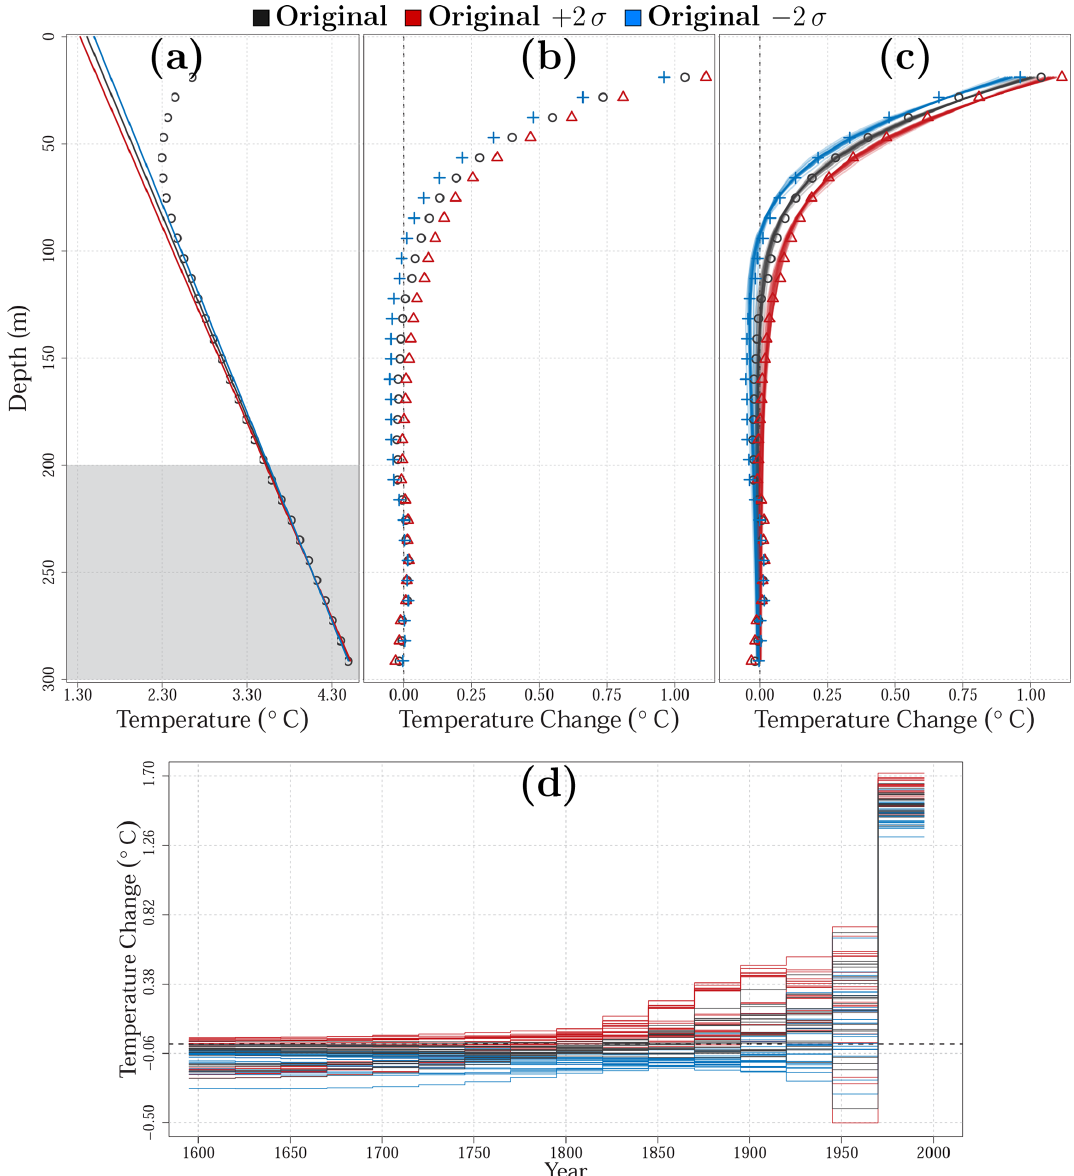
Figure 2. Borehole temperature profile measurements at Fox Mine (CA_9519), Manitoba (Canada), as an example to explain the inversion approaches in this study. (a) Observed original profile (black dots), the estimated subsurface quasi-equilibrium temperature profile (black line), and the two extremal temperature profiles (red and blue lines) displaying the error in determining the quasi-equilibrium profile. All three equilibrium profiles were estimated from the linear regression analysis of the deepest part of the measured profile (from 200 to 300m, grey zone). (b) Anomaly profiles estimated by subtracting the three equilibrium profiles from the original temperature profile. (c) As in (b) , but including the 243 synthetic profiles generated from the corresponding ground surface temperature histories constituting the PPI ensemble of this borehole (red, blue and black shades). (d) Final ensemble of ground surface temperature histories considered for estimating the 5th, 50th, and 95th weighted percentiles for this borehole. Each history is weighted depending on its performance against the corresponding anomaly profile (c)